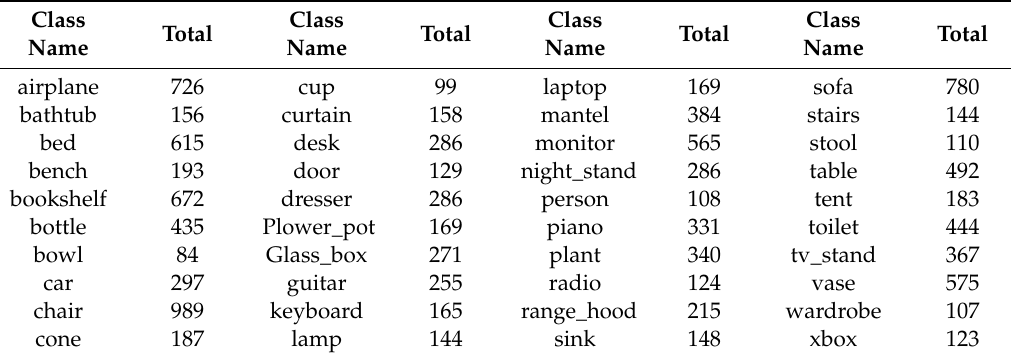
Table 2. Classes distribution of